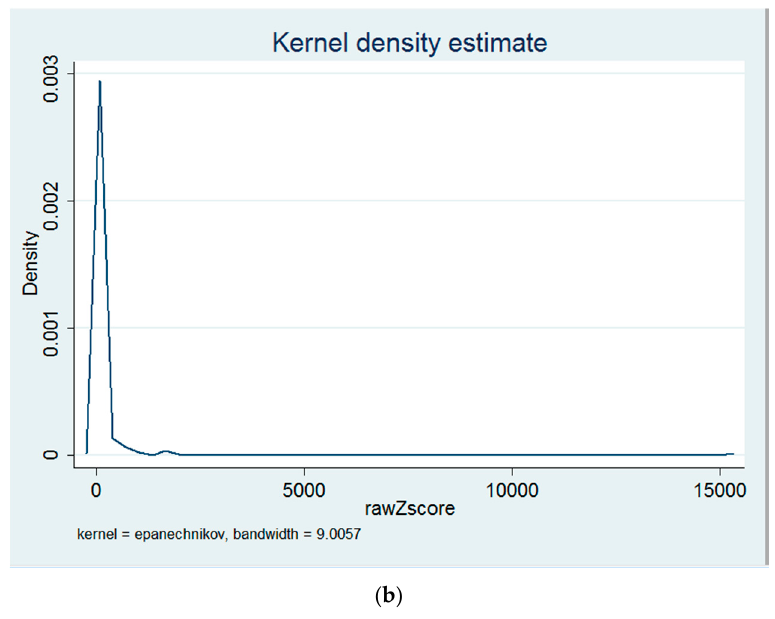
Figure 1. Kernel density estimation of Z-score: ( a ) the results of kernel density estimation of raw Z-score; and ( b ) the nature logarithm of Z-score.